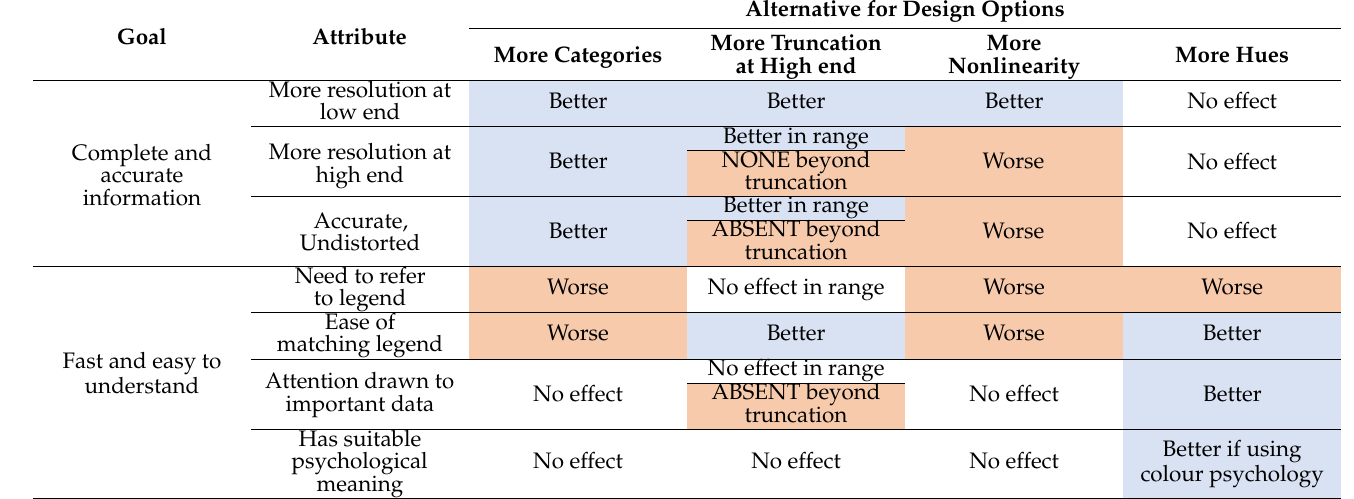
Table 5. Tabulation of how alternatives for the number of categories, amount of truncation and nonlinearity and number of hues generally interact in affecting several attributes related to completeness and accuracy of information or speed and ease of understanding. There are exceptions for some combinations and boundary conditions. Every alternative improves some attributes (blue-grey shading) and worsens others (orange-tan